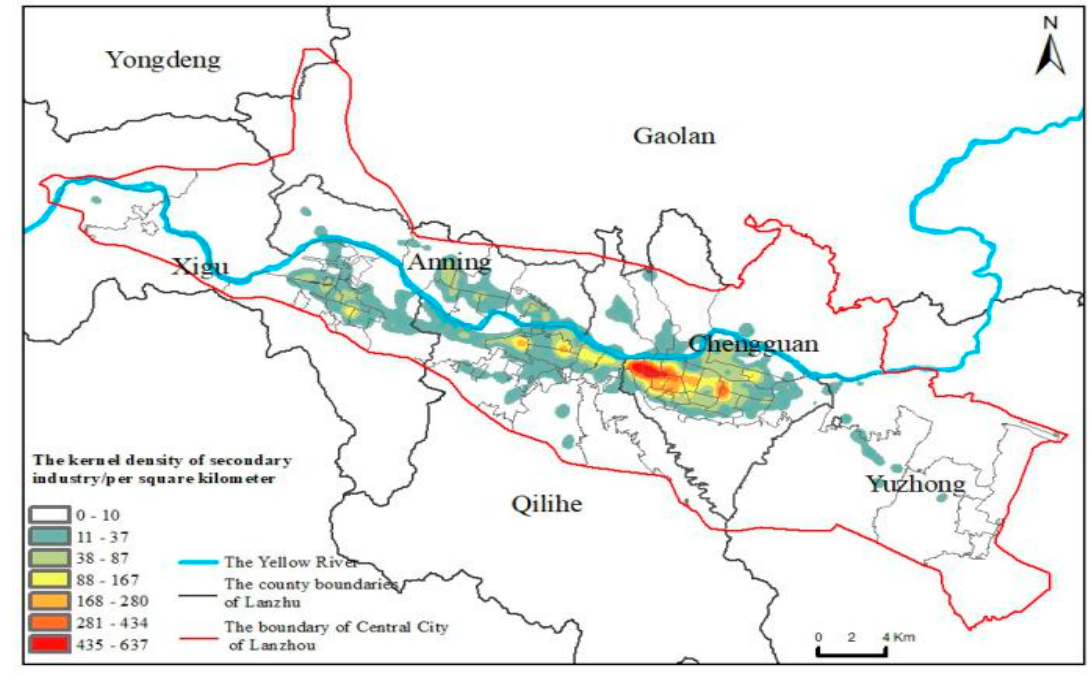
Figure 6. The kernel density distribution of secondary industry